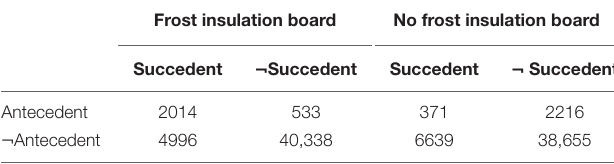
TABLE 7 | Contingency tables for analytical question 3 hypothesis.